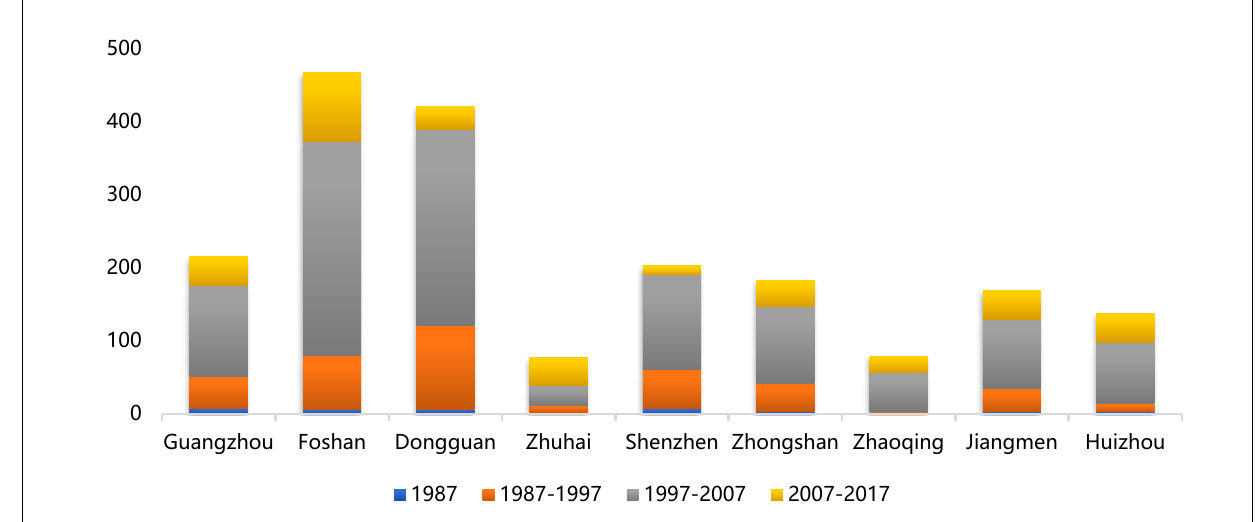
Figure 6. Statistics of manufacturing production space areas in each city.